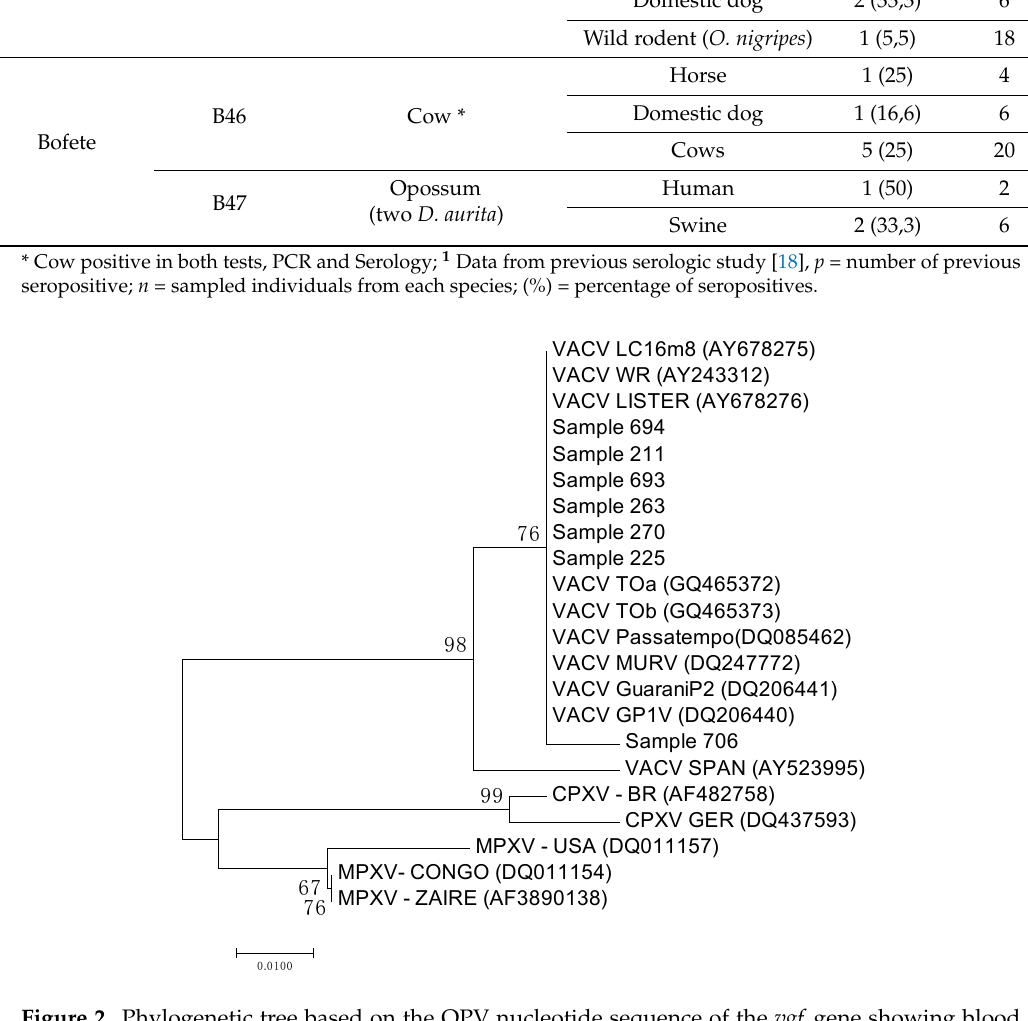
Table 4. Farms in which VACV DNA were detected by PCR in blood samples and previous seropositivity of animals and humans from these DNA positive farms.